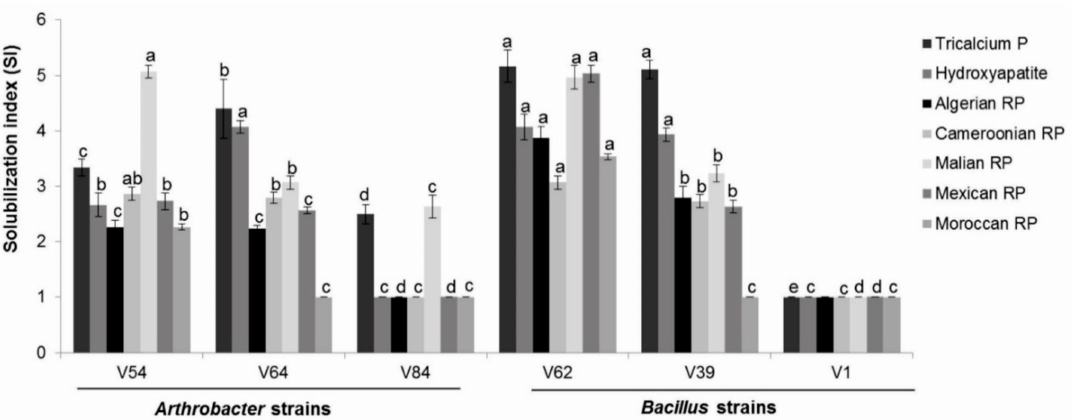
Figure 1. The e ffi ciency of bacterial strains to solubilize inorganic phosphate sources on solid media. The solubilization index of three Arthrobacter (V54, V64, and V84) and three Bacillus (V62, V39, and V1) strains for the seven di ff erent inorganic phosphate sources, as measured on solid agar plates. The results are the means of three replicates. Error bars represent the standard deviation. Di ff erent letters indicate significant di ff erences between bacterial strains within the same phosphate source ( p < 0.05) using the Tukey HSD test. RP = rock